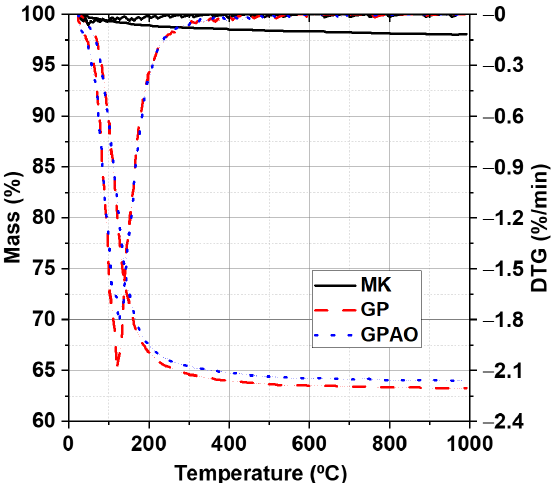
Figure 7. TGA/DTG profiles for the MK and the prepared GP and GPAO.